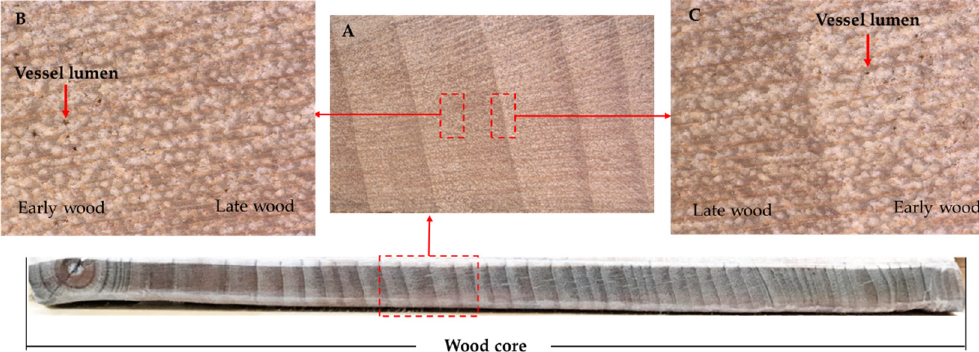
Figure 1. The cross section of wood core of S . superba in 54-year-old. ( A ) Locally enlarged part of wood core, the pale band was early wood and the dark band was late wood. ( B ) The transition between early wood and late wood on a left-to-right time axis. The early wood had larger vessel lumen and more vessel elements, while the late wood had smaller vessel lumen and less vessel elements. ( C ) The annual ring border between late wood and early wood.